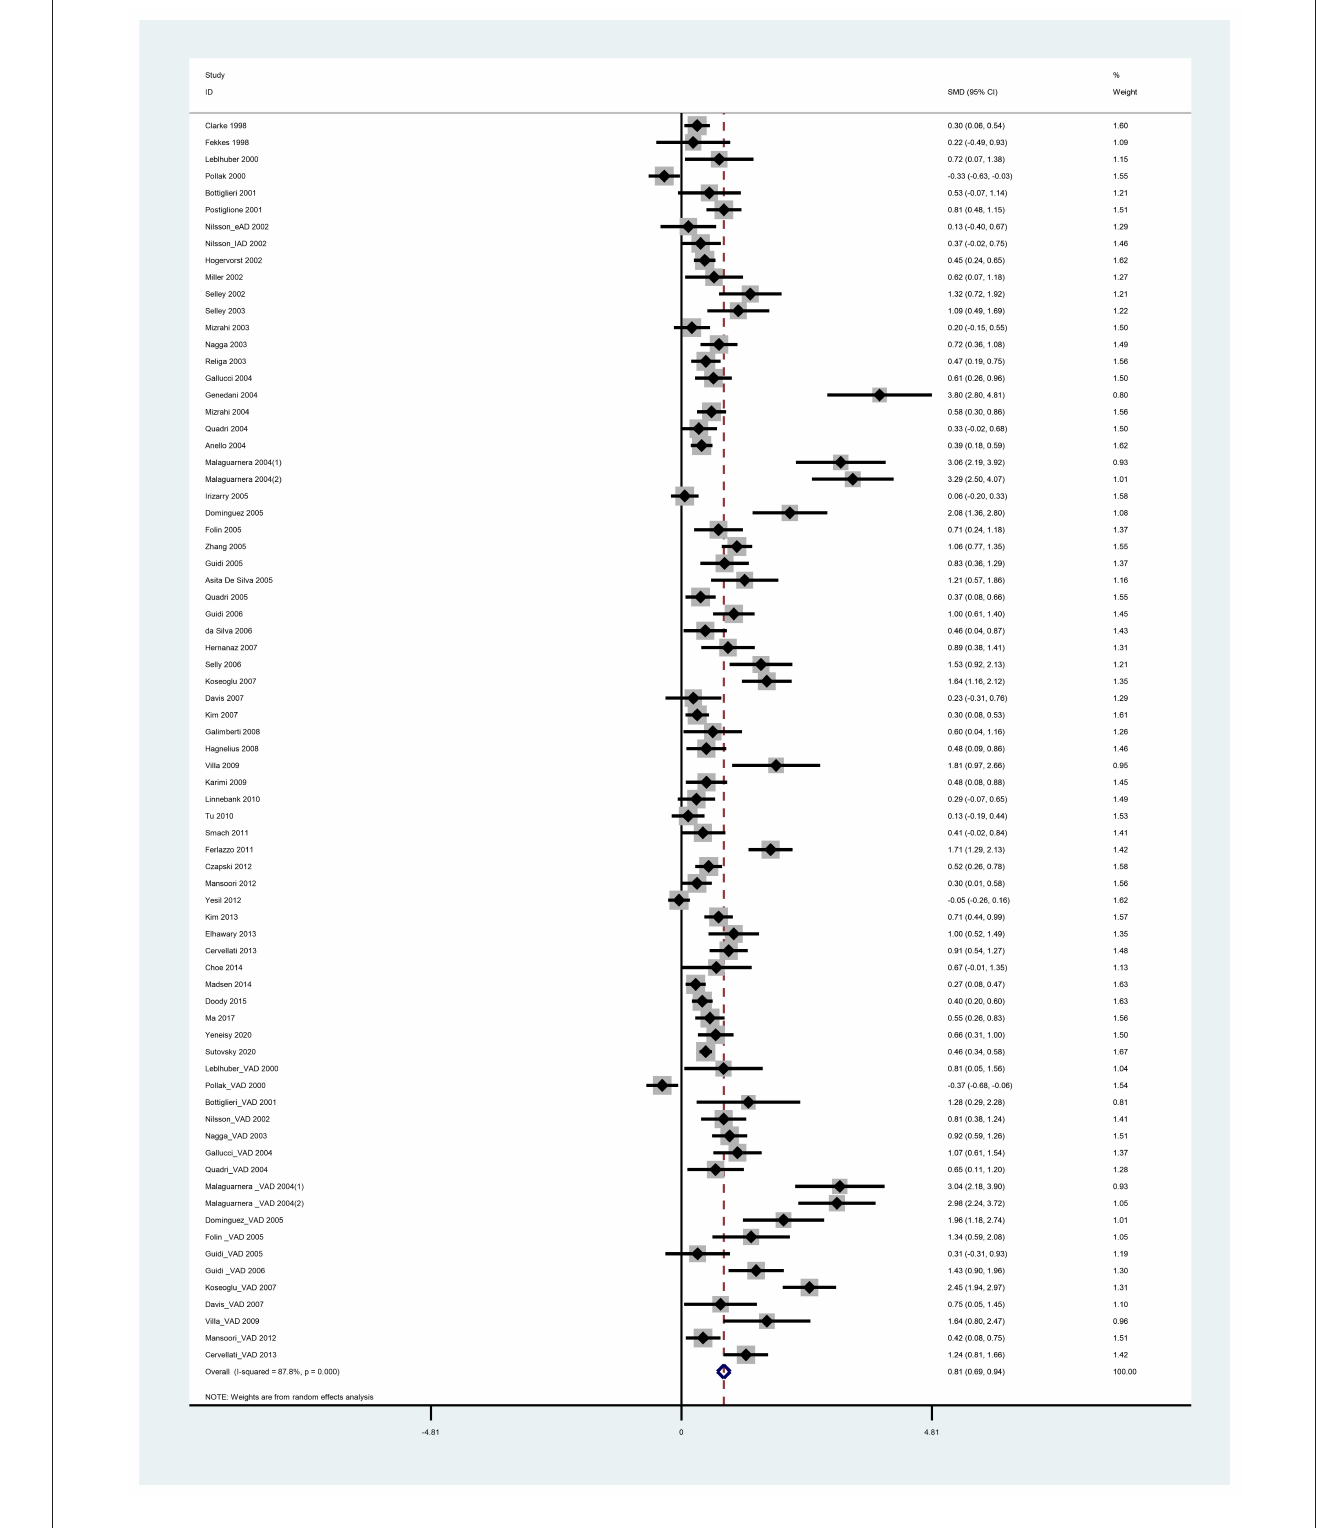
FIGURE 2 | Forest plot of standard mean difference (SMD) and 95% confidence interval (95%CI) in dementia and control group for plasma homocysteine.